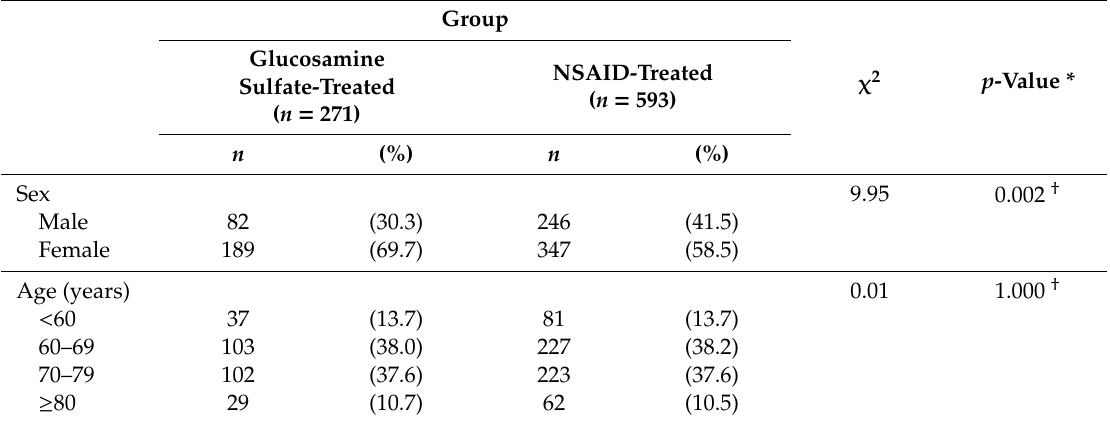
Table 2. Sex and age distributions of glucosamine sulfate-treated and NSAID-treated groups. Group